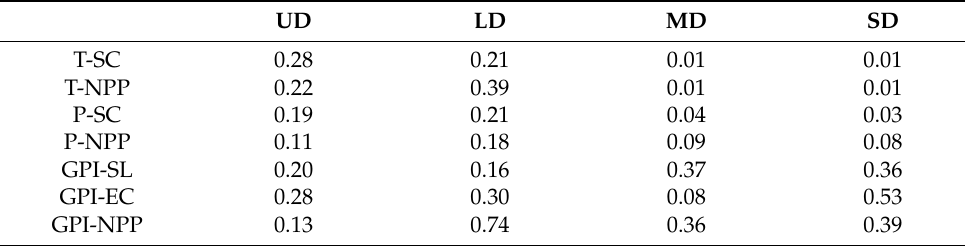
Table 3. Effects of climate change and grazing pressure on the relationship between grassland degradation and ecosystem services under different degradation